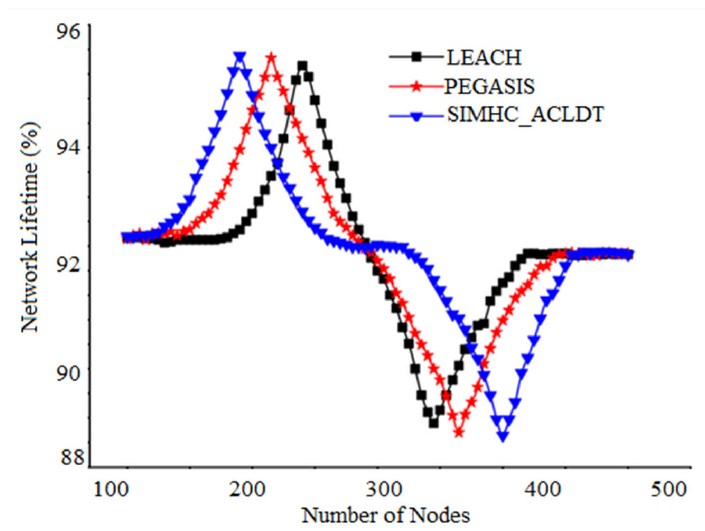
Figure 2. Comparative analysis of network lifetime.